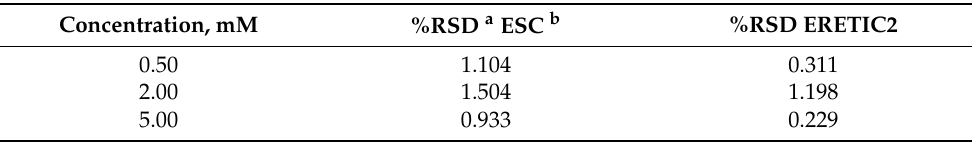
Table 5. Interday precision results (average results given, n = 3) obtained by ESC and ERETIC2 (based on the PULCON